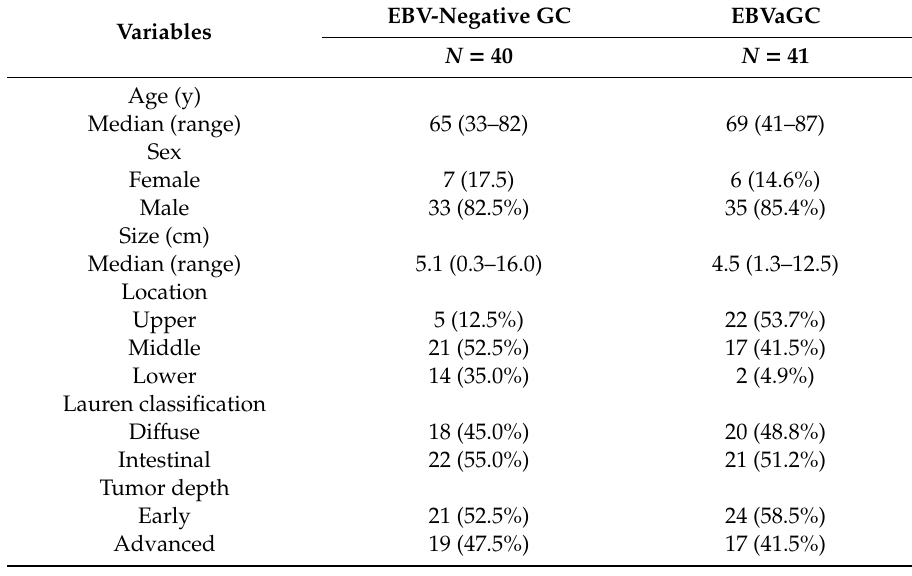
Table 3. Clinicopathological characteristics of gastric cancer cases used for this study.